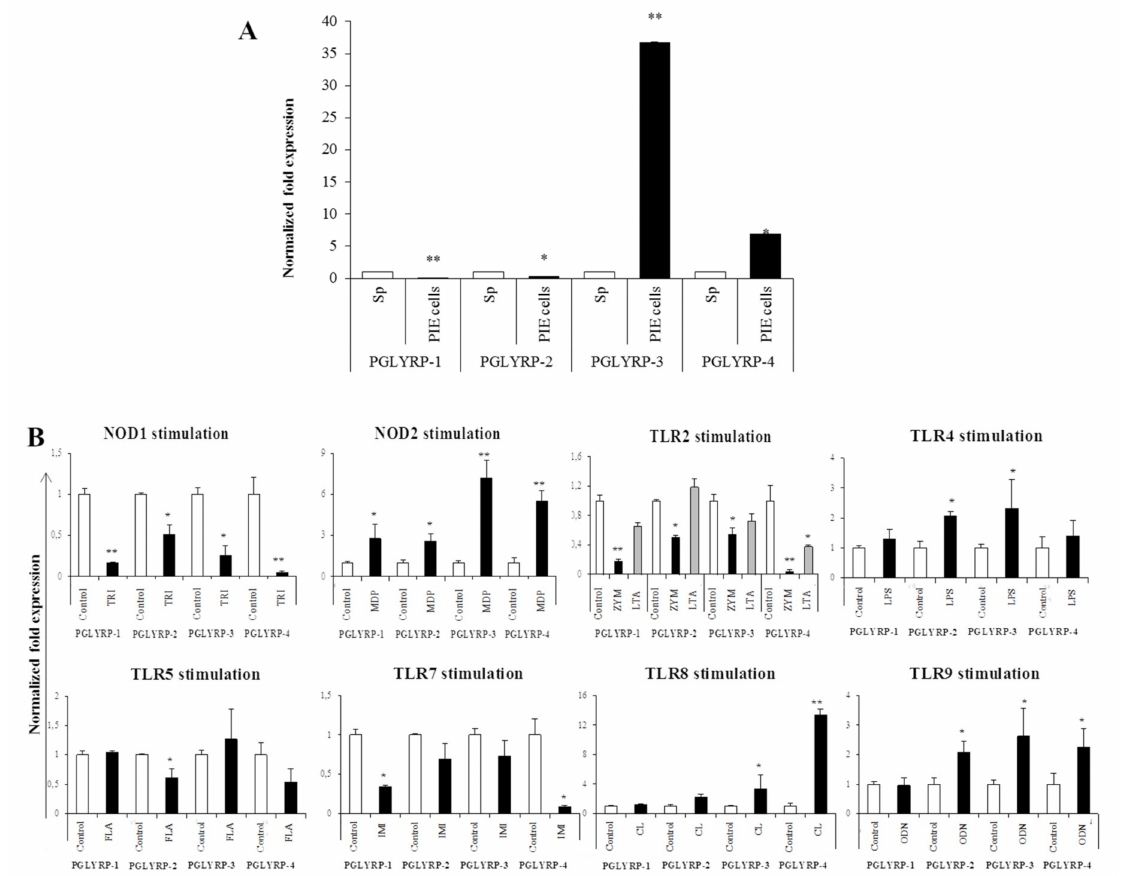
Figure 4. Peptidoglycan recognition proteins (PGLYRPs) expression in porcine intestinal epithelial (PIE) cells and their modulation by pattern recognition receptor (PRR)-ligands. Expression of PGLYRP-1, -2, -3, and -4 in the porcine spleen and in PIE cells without stimulation ( A ). Modulation of PGLYRP-1, -2, -3, and -4 expressions in PIE cells after stimulation with eight di ff erent PRR-ligands ( B ). Zymosan (ZYM) and lipoteichoic acid (LTA) were used as TLR2-ligand. Lipopolysaccharide (LPS), flagellin (FLA), imiquimod (IMI), CL075 (CL), ODN2006 (ODN), muramyl tripeptide (DAP), and muramyl dipeptide were used as ligands for TLR4, TLR5, TLR7, TLR8, TLR9, NOD1, and NOD2, respectively. Expressions of PGLYRP mRNA level was normalized using the porcine β -actin mRNA, and the relative index was determined by comparison to the PGLYRP mRNA level in non-stimulated PIE cells (1.00). Values represent the means ± standard deviation obtained from three independent experiments ( n = 6). * p < 0.05 and ** p < 0.01 against control